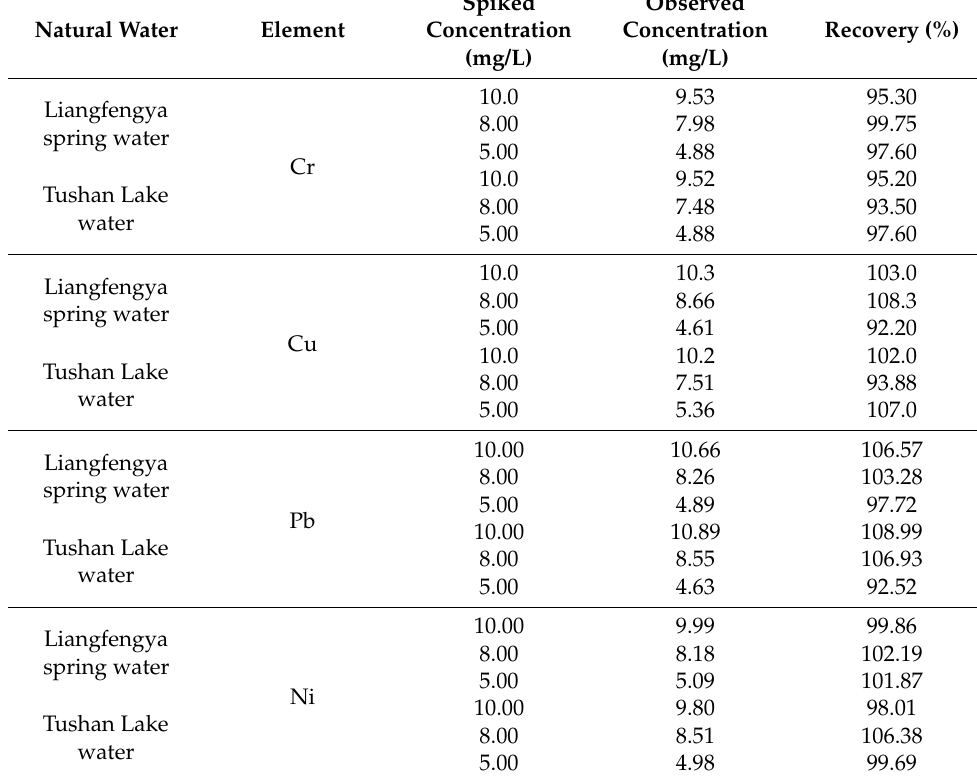
Table 3. Concentration and recovery of natural spring